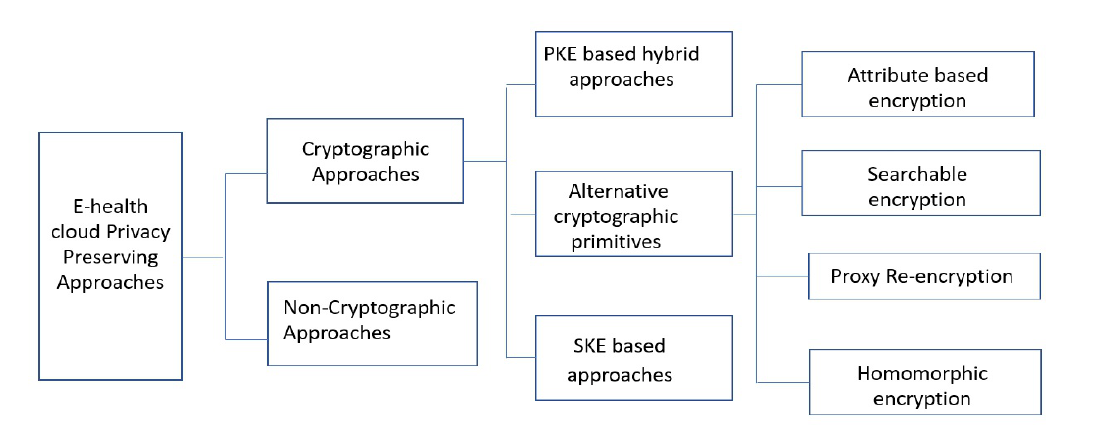
Figure 1. Taxonomy of the privacy preserving approaches in the e-Health